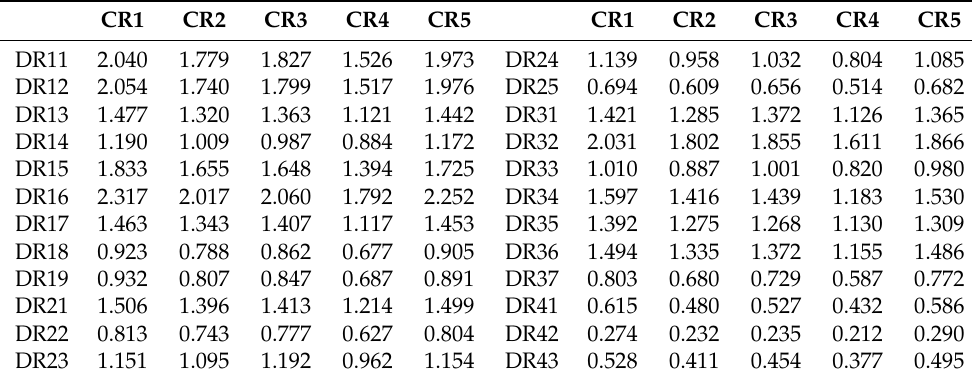
Table 10. Ranking matrix W of the influence relationship of DRs.